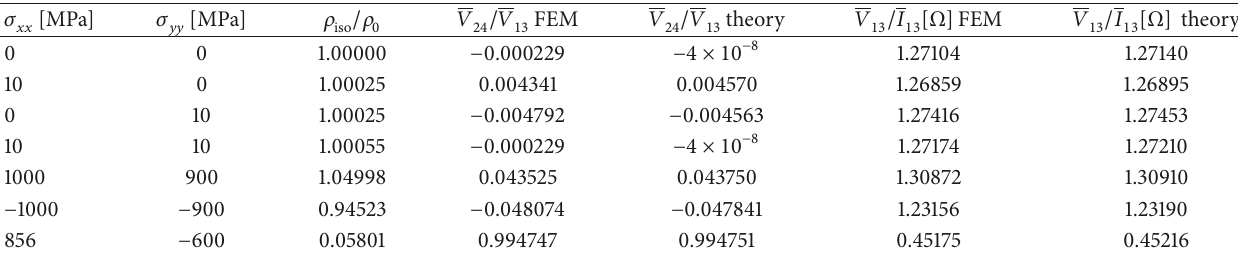
Table 1: Mechanical stress sensitivity of rectangular device from Figure 9: comparison of numerical simulation (FEM) versus